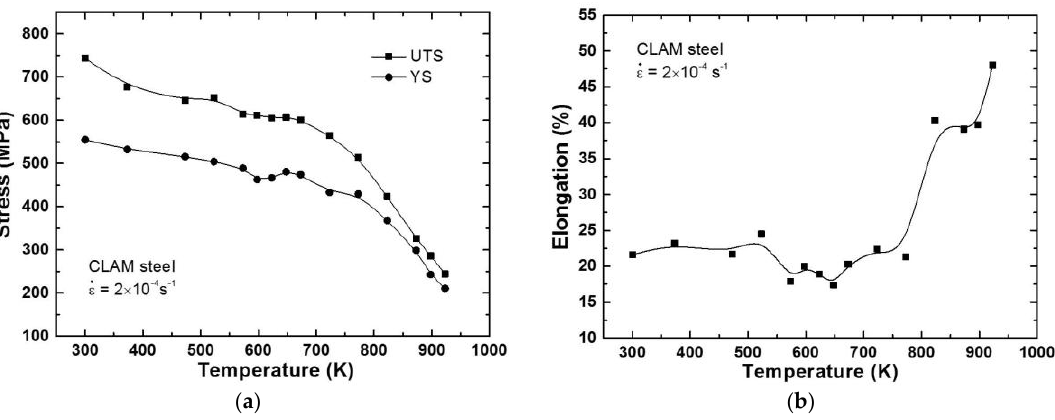
Figure 3. Variation of tensile properties with temperature at the initial strain rate of 2 × 10 −4 s −1 in China low activation martensitic (CLAM) steel: ( a ) ultimate tensile strength (UTS) and yield strength (YS); ( b ) total elongation.